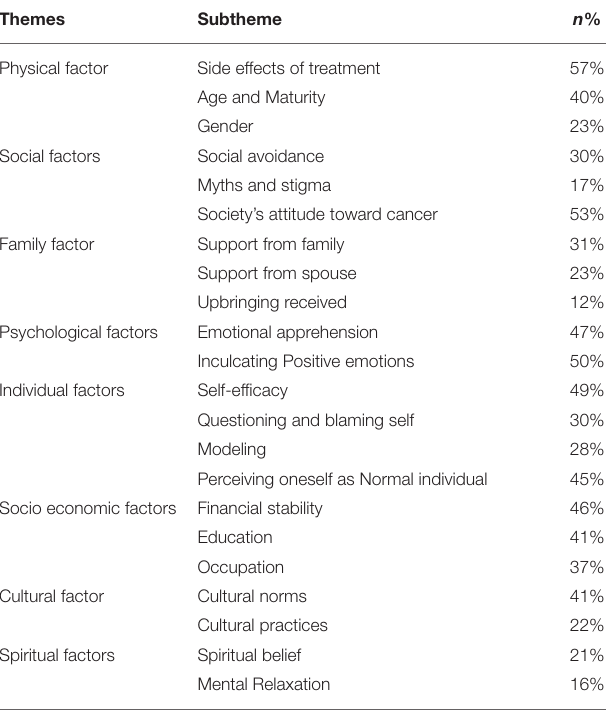
TABLE 2 | Themes, subthemes, and categories identified, their codes and n